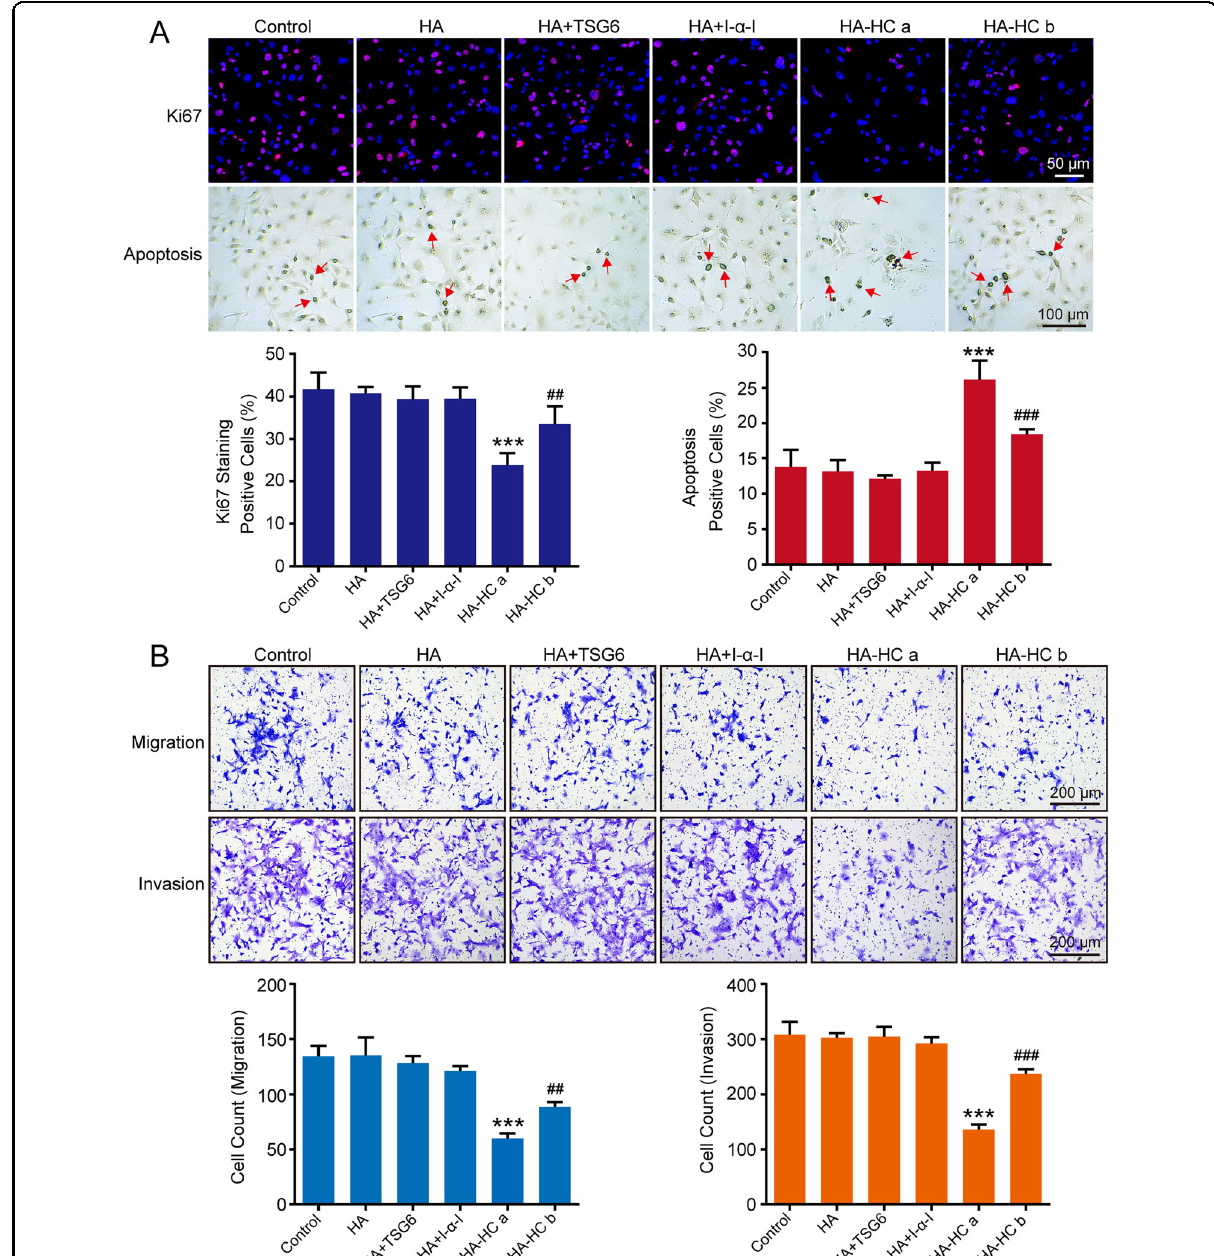
Fig. 5 HA cross-linking constructed in vitro suppressed breast cancer malignancy. A After treatment with HA, HA + TSG6, HA + I- α -I, HA-HCa (HA + I- α -I + TSG6), or HA-HCb (HA + I- α -I + 1/2 concentrated TSG6), the proliferation and apoptosis of MMTV tumor cells were determined. Red nuclei refer to the Ki67-positive ones, and red arrowheads refer to the apoptotic tumor cells. B The migration and invasion abilities of tumor cells in different groups. All experiments were repeated three times with similar results. Error bars represent mean ± SD values. Statistical analysis was performed using Student ’ s t test. *** p < 0.001 (vs Control), ## p < 0.01, ### p < 0.001 (vs